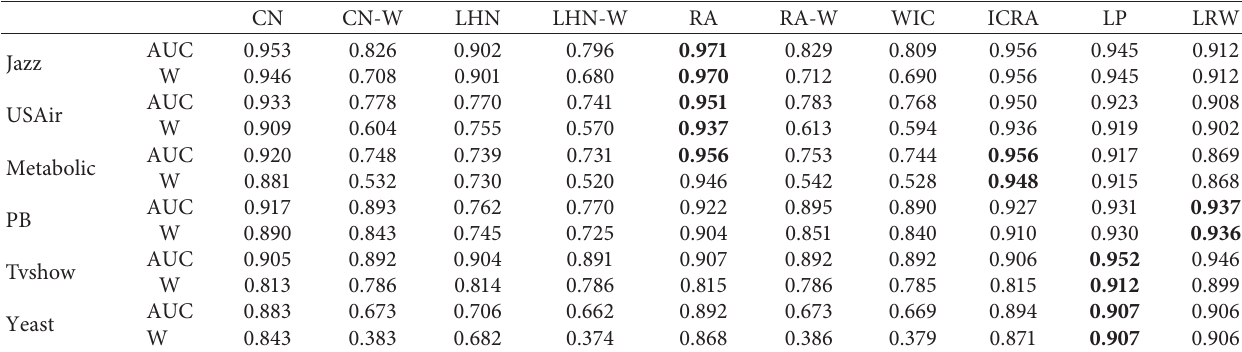
Table 3: The prediction accuracy on six